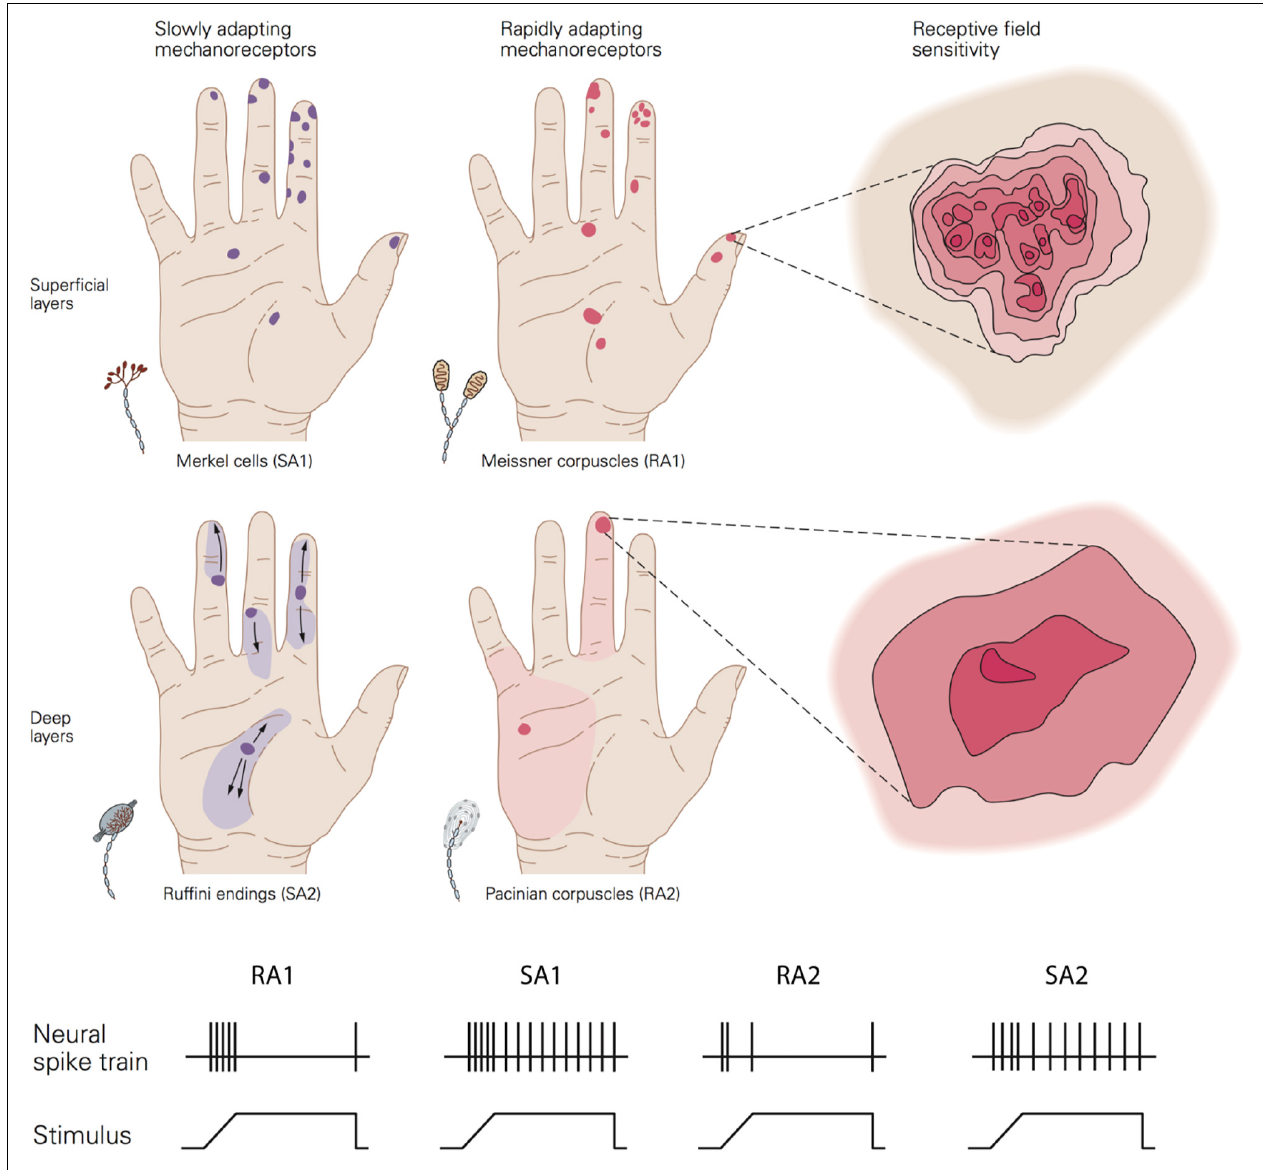
FIGURE 3 | Top image shows a schematic view of the distribution, size, and sensitivity map of the receptive field of the four afferent types. Bottom image show the typical adaptation of the four afferent types in response to a ramp-and-hold indentation. Republished with permission of McGraw Hill LLC, from Kandel et al. (2013) 5/E; permission conveyed through Copyright Clearance Center,